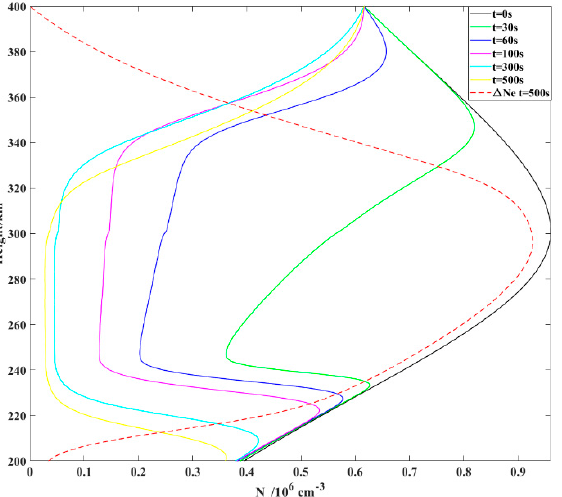
Figure 3. The vertical profile of electron density at different times after the release of CO 2.